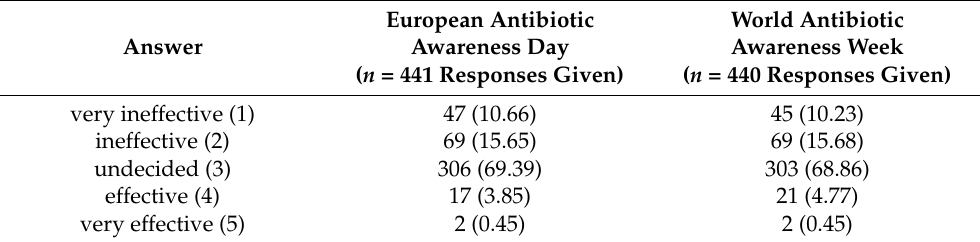
Table 8. Respondents who believe European Antibiotic Awareness Day and World Antibiotic Aware- ness Week have been effective/ineffective in raising awareness about prudent use of antibiotics and antibiotic resistance in their country ( n =